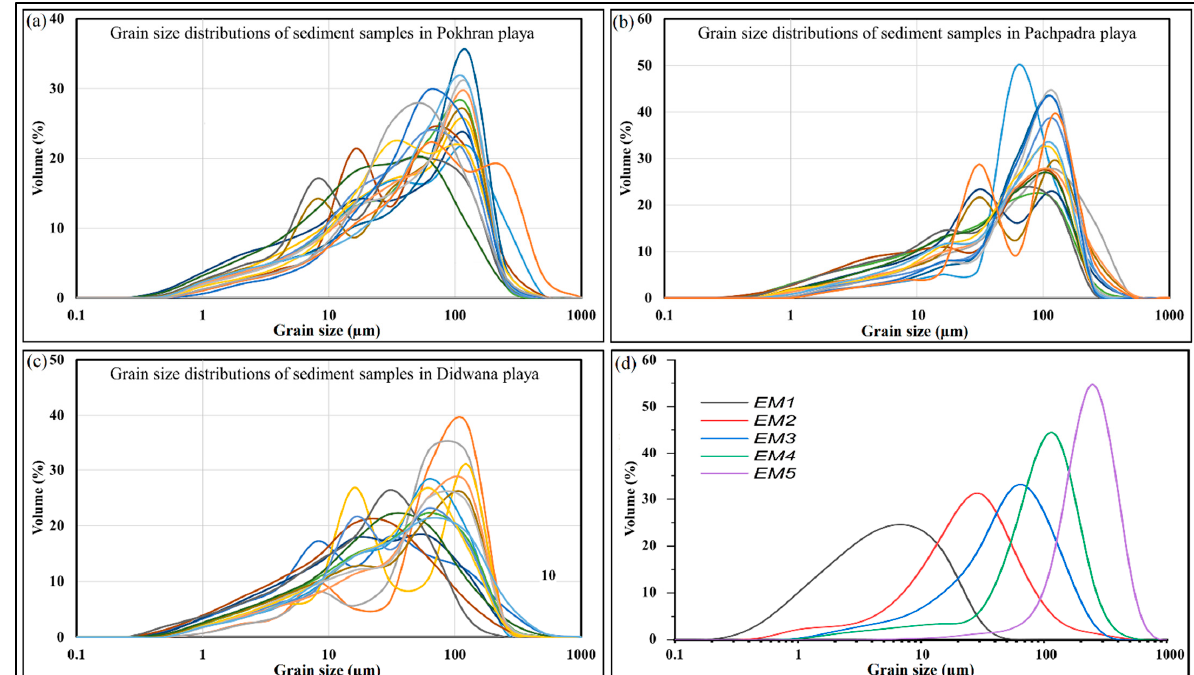
Figure 6. Grain size distributions of sediment samples from ( a ) Pokhran playa, ( b ) Pachpadra playa, ( c ) Didwana playa, and ( d ) Representative five EMs resulting from modelling. EM-3 (model peak of 63 µm) is coarser than EM-2 (model peak of 31 µm) and EM-1 (model peak of 8 µm), indicating that shorter transport pathways result in coarser grain particles to playa lakes, whereas long transport pathways result in fine-grain particles (EM-1 and EM-2) to playa lakes. Sediment fractions with Mz less than 63 µm in the playas indicate aeolian deposition, a wind-transported particle. Similar observations were re- ported by Wu [75] at playa of Ebinur Lake, Arid Central Asia, and Abbasi [76] at Iran’s ephemeral Baringak Lake. However, aeolian sediment is generally well-sorted and uni-